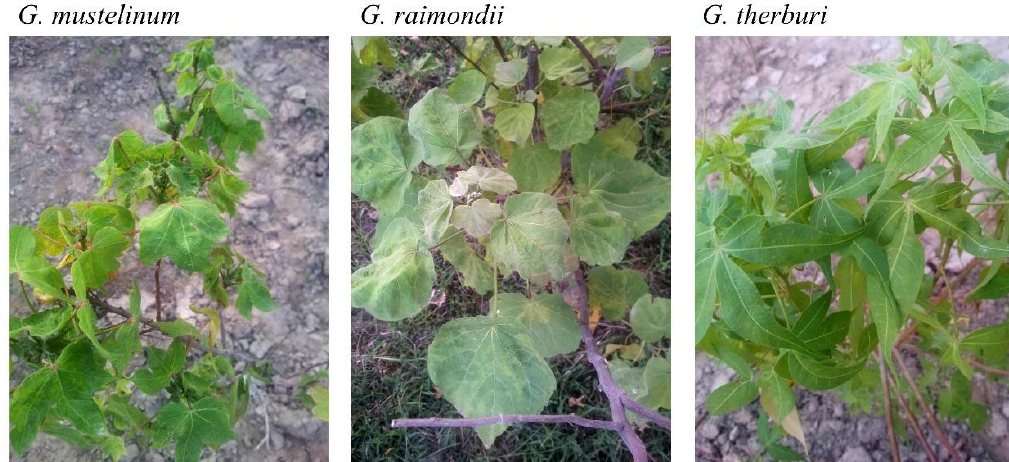
Figure 1. Gossypium species used in this study. G. mustelinum, G. raimondii and G. thurberi plants, maintained at the Central Cotton Research Institute (CCRI), Multan, Pakistan.